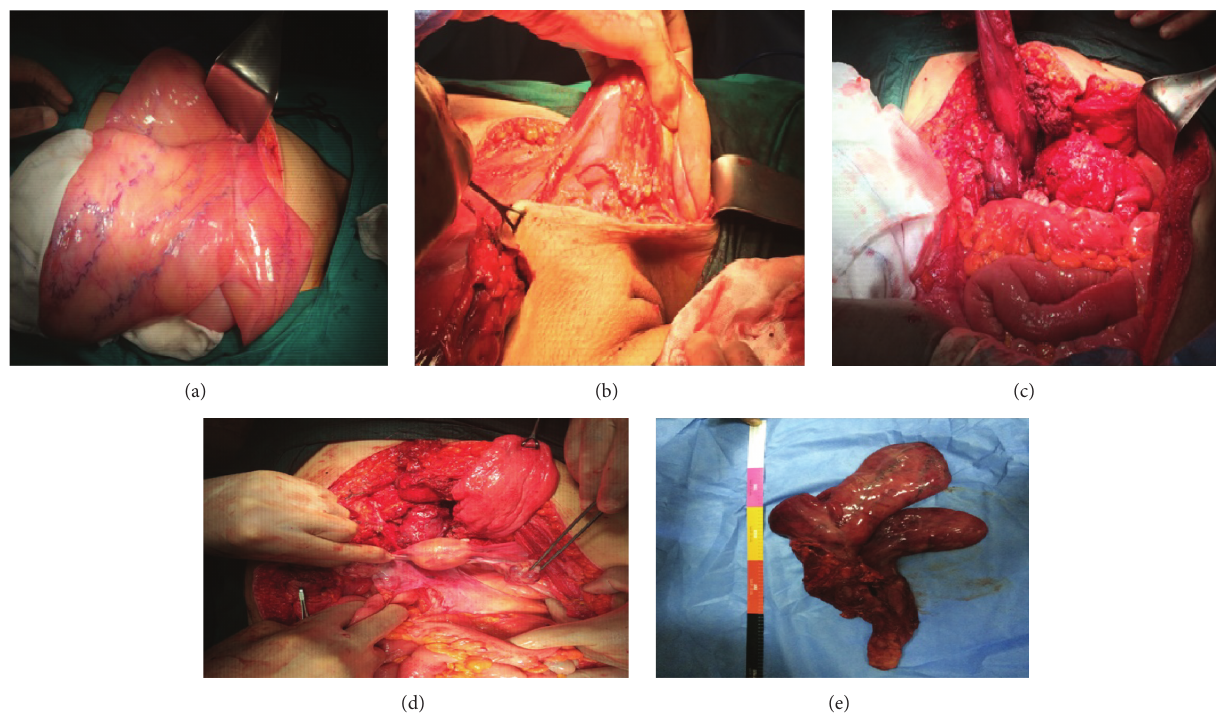
Figure 2: Operative findings of the tumor. (a) Macroscopic view of the tumor. (b) Extension of the tumor to the left thigh. (c) The radix of the tumor. (d) Abdominal view after accomplishing the surgery. (e) Resected